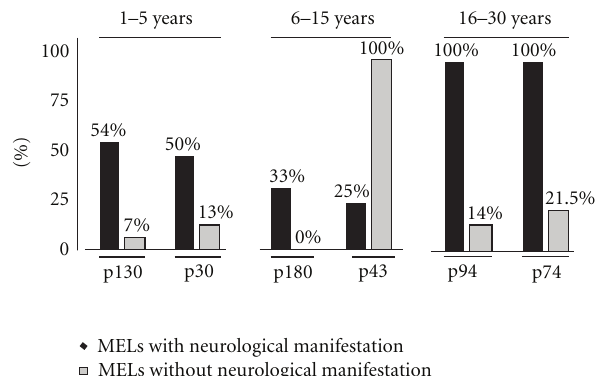
Figure 3: Evolution of IgG autoreactive patterns related both to age groups and clinical status within MEI. In each age group, distinct discriminant antigenic bands were found: p130 and p30 (1–5 years), p180 and p43 (6–15 years), and p94 and p74 (16–30 years). The respective frequencies of these bands were given for MEI with (black diagram) or without (grey diagram) neurological